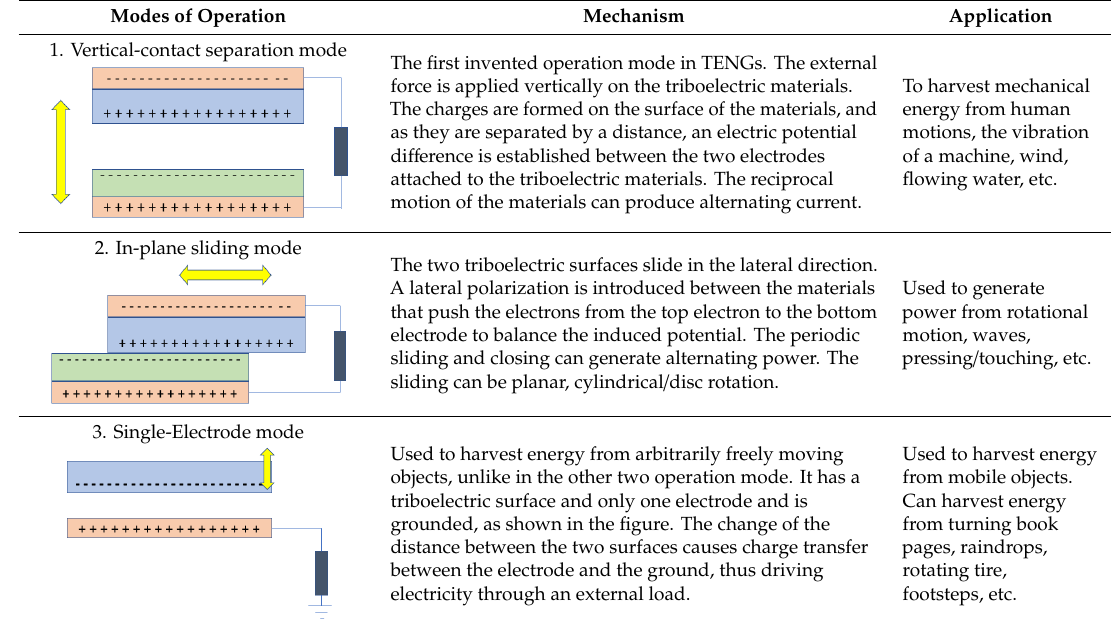
Table 3. Comparison of the working principle of various modes of operation of